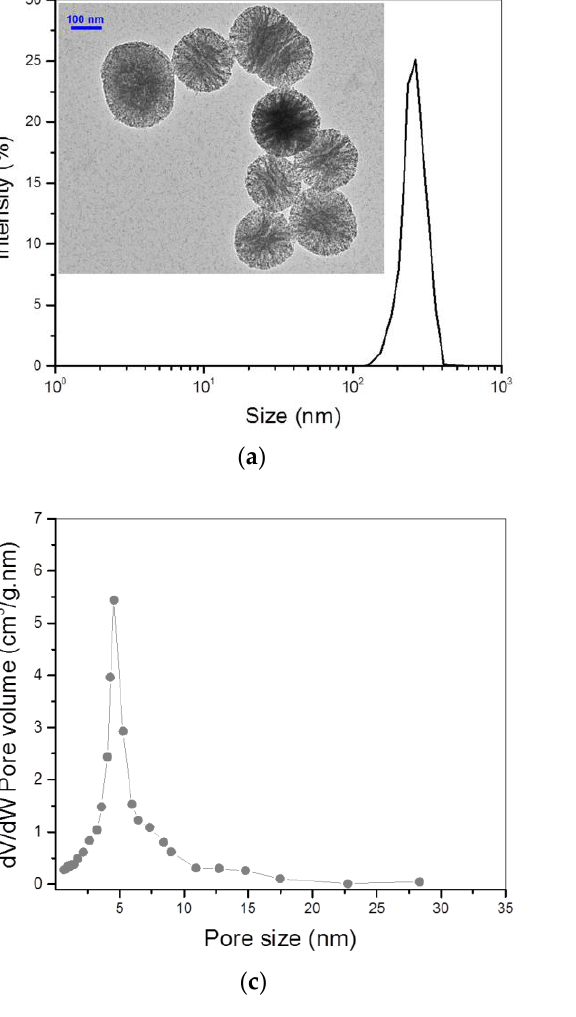
Figure 2. Size distribution with inserted TEM micrograph ( a ), nitrogen adsorption–desorption isotherm ( b ), pore-size distribution ( c ) and EDX spectrum ( d ) for BG NPs. Table 1. Parameters for different kinds of nanoparticles.